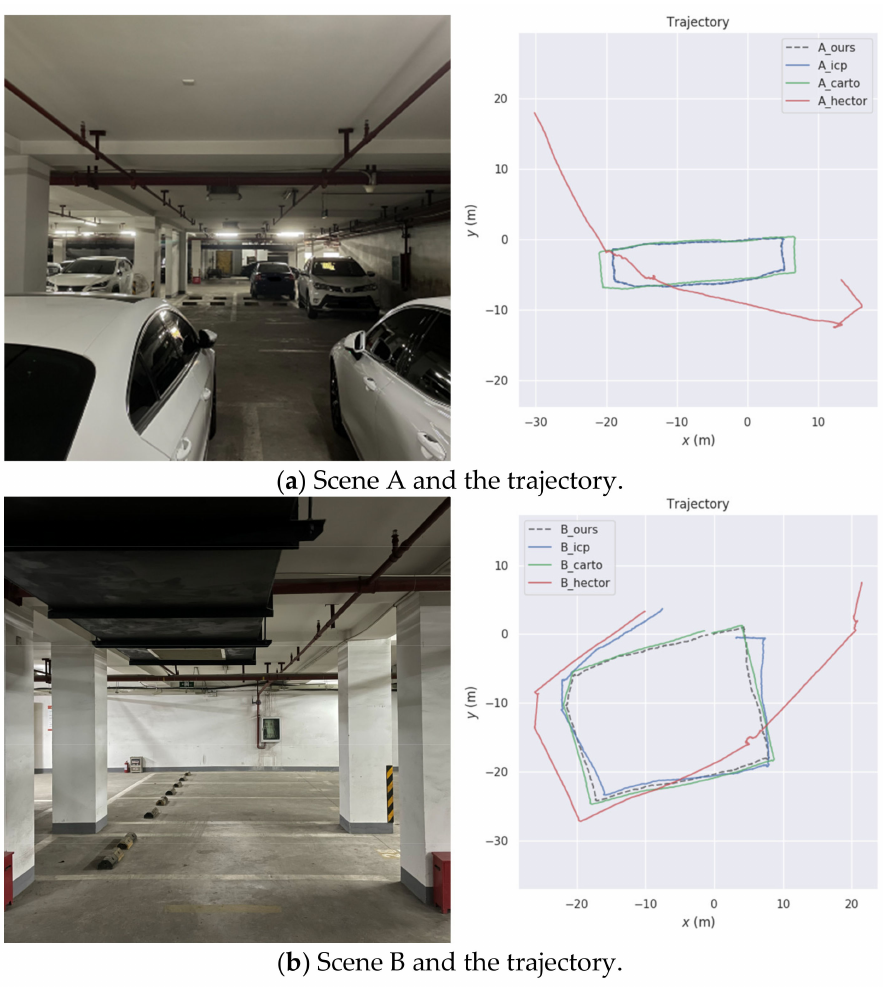
Chart 1. Relative errors of motion estimation drift for different algorithms. A, B, C represent the datasets of different scenes in the garage. D is the dataset of